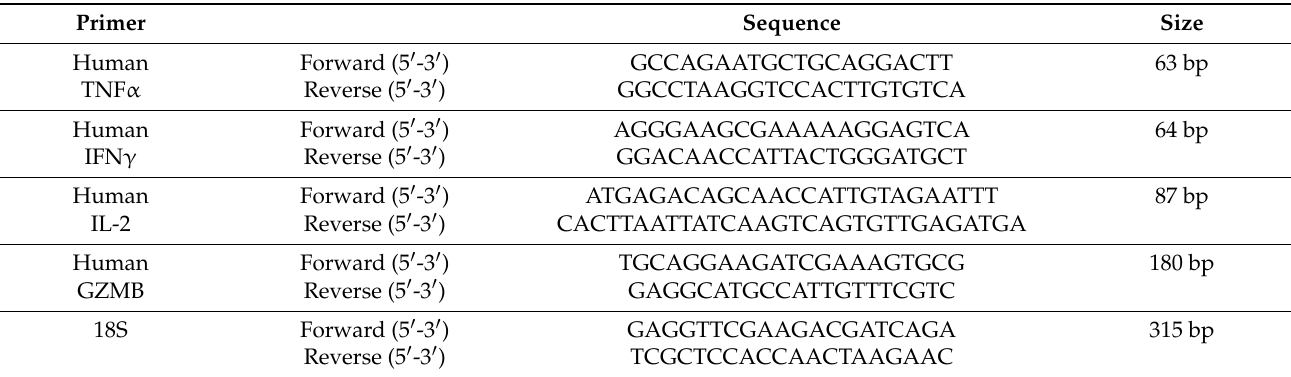
Table 1. Primers used for